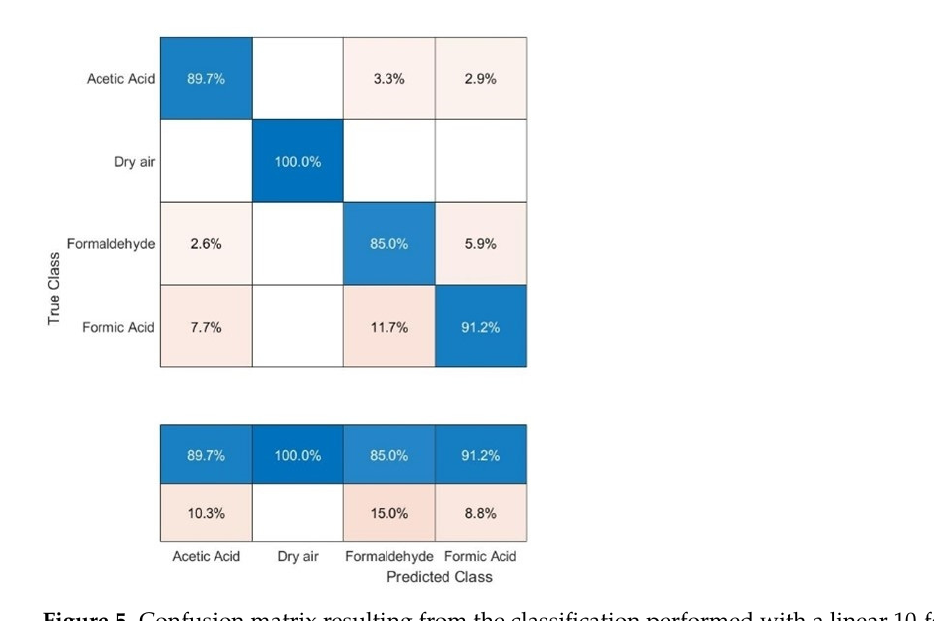
Figure 5. Confusion matrix resulting from the classification performed with a linear 10-fold cross- validated support vector machine model where each group, except for dry air, includes seven different concentrations ranging from 250 to 3000 ppb.